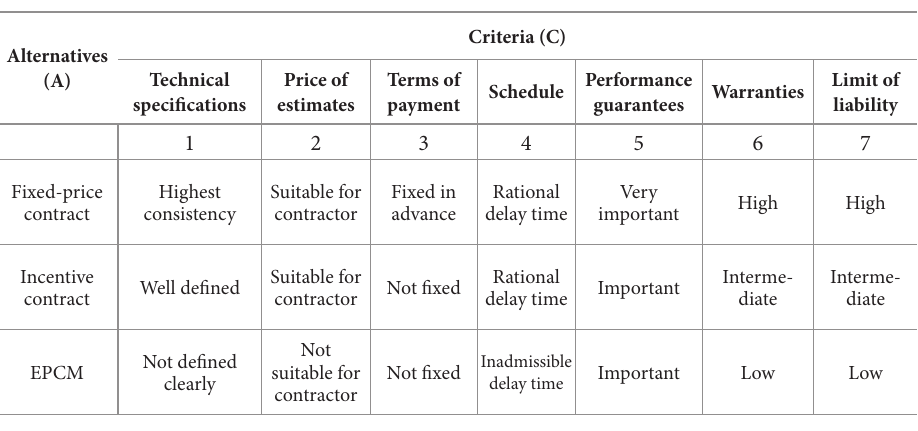
Table 3. Available contract alternatives